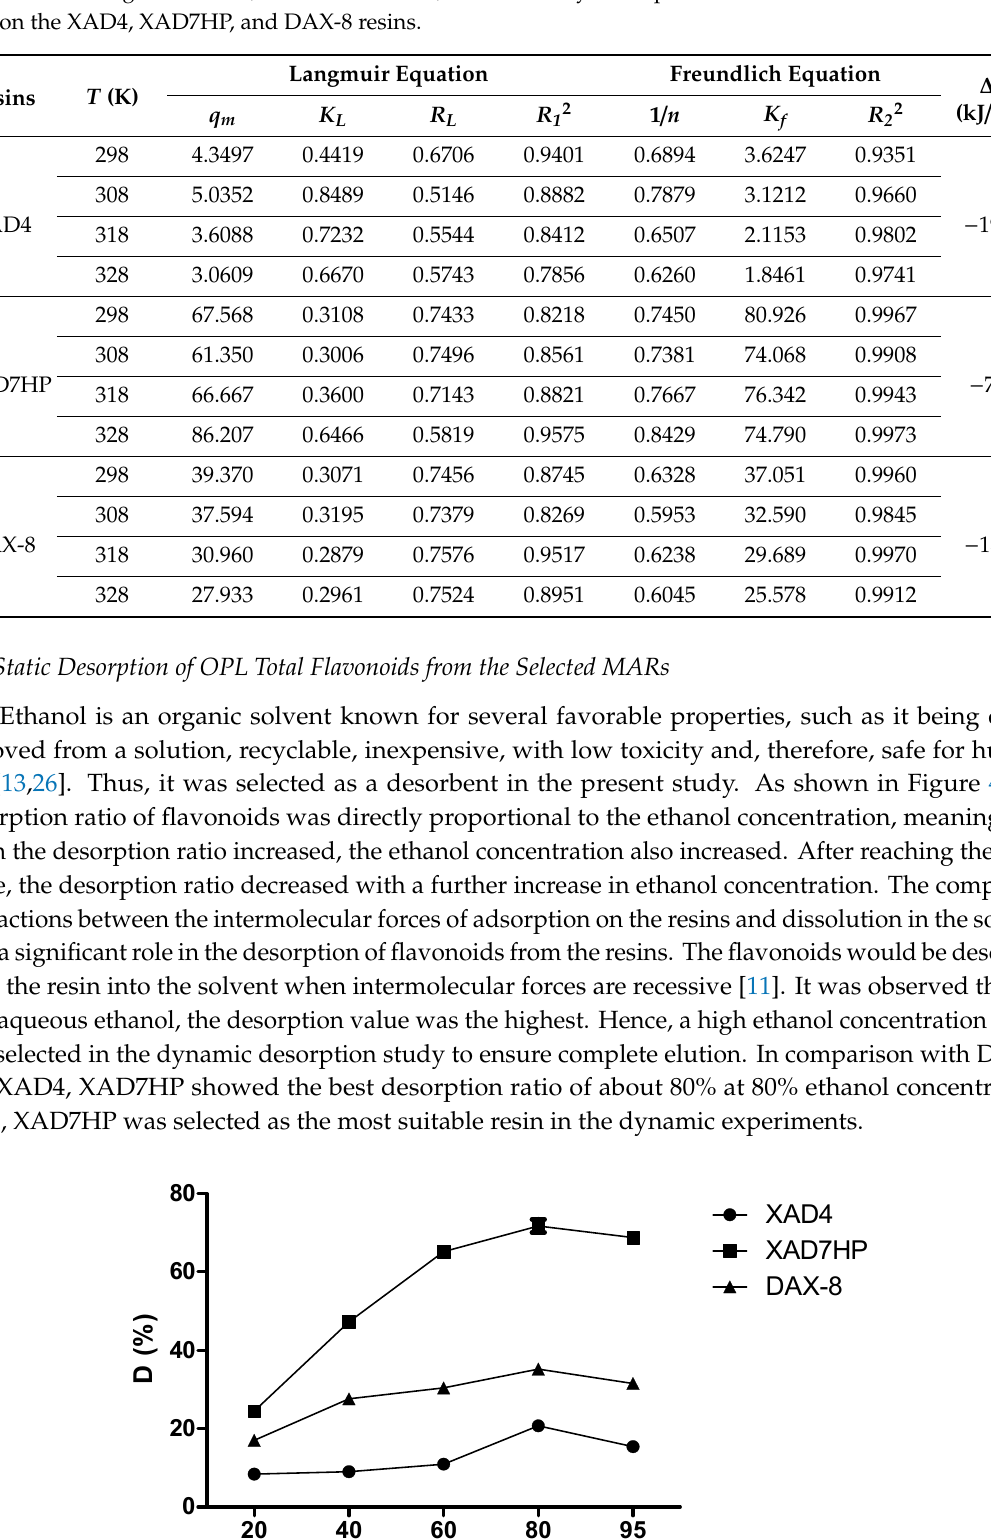
B Figure 5. Dynamic breakthrough ( A ) and desorption ( B ) curves for OPL total flavonoids on XAD7HP. The dynamic desorption curve for XAD7HP was plotted from the volume of the eluting desorption solution and the TFC of the desorbed solution. As displayed in Figure 5B, the OPL total flavonoids could be completely desorbed after elution with 180 mL of 80% aqueous ethanol. The eluted desorbed solution was pooled and evaluated for its TFC. The TFC value of the desorbed solution was 487.97 mg QCE/g, which was a 3.57-fold increase compared to the initial TFC of the original OPL extract of 136.69 mg QCE/g. 2.5. UHPLC–UV/PDA and UHPLC–MS/MS Analysis of Crude and Total Flavonoid-Enriched OPL Extracts Figure 6 reveals the comparison of compounds present in a crude extract and an extract after enrichment with XAD7HP macroporous resin. The peaks were putatively identified after analyzing